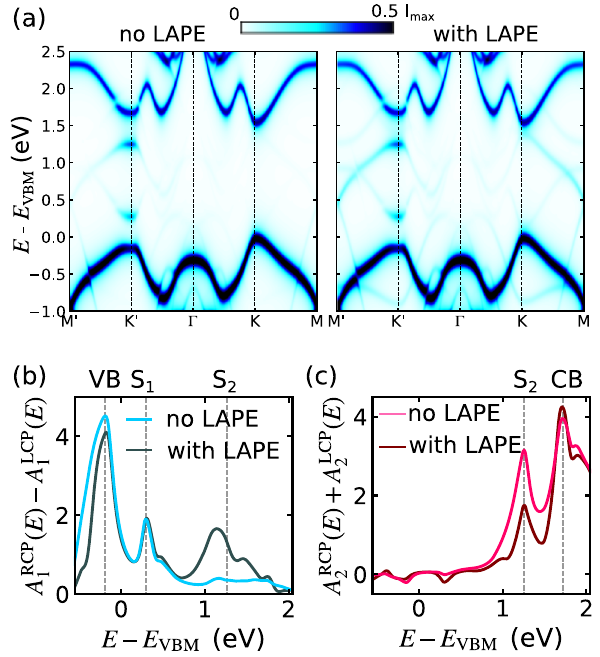
Fig. 7 Effects of LAPE on spectra and dichroic markers. a Comparison of the unpolarized trARPES signal I av ( k , E ) without (left panel) and with (right panel) including laser-assisted photoemission (LAPE), for an left-hand circularly polarized (LCP) pump and the crystal orientation as in Fig. 6a. b , c Time-reversal difference of the dichroic markers as in Fig. 6f, g including LAPE (RCP: right-hand circularly polarized). The pump strength is E = 2 × 10 − 3 a.u. and the bath coupling is set to Γ = 0.1 eV in all 0